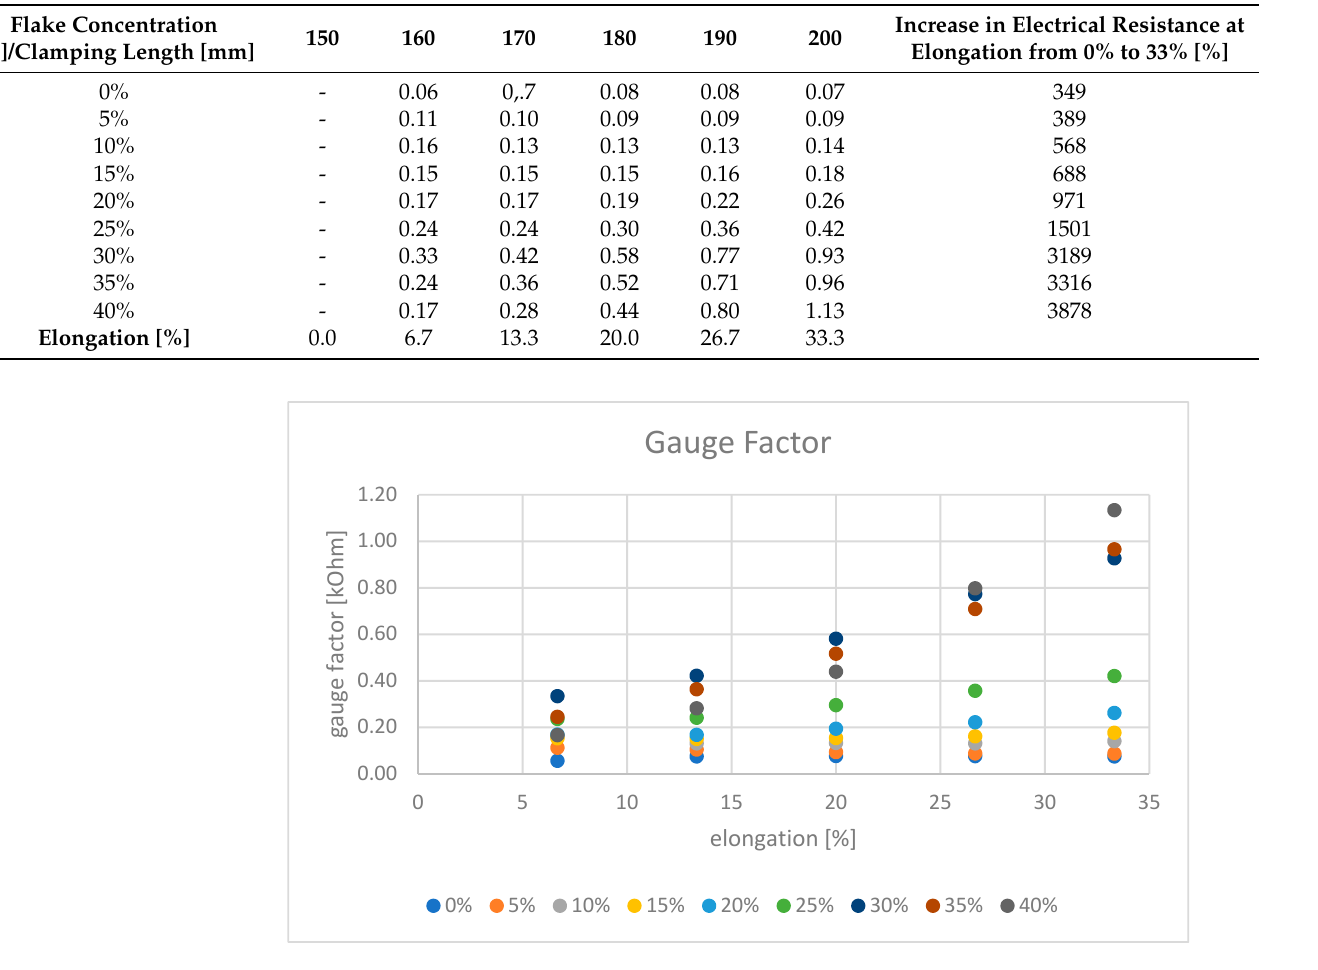
Figure 10. Gauge factors for different concentrations of Ag35200 flakes in dependency on elongation.